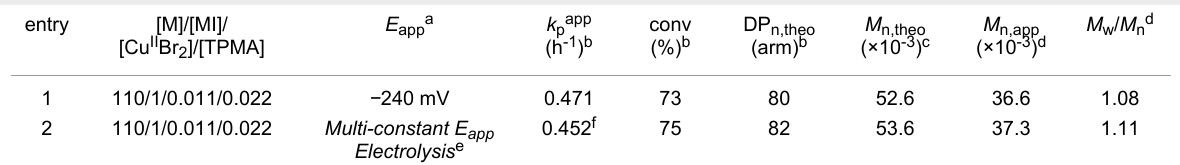
Table 1: Summary of quercetin-based pseudo -star polymers synthesis by se ATRP.